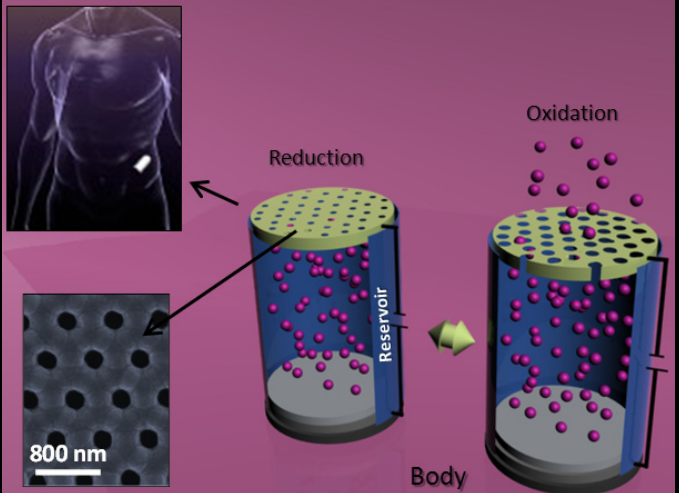
Figure 22. Implant constituted by electrically actuable nanoporous membranes (based on [92]): nanoporous are closed at the reduction state due to PPy expansion whereas are open at the oxidation state making feasible the drug